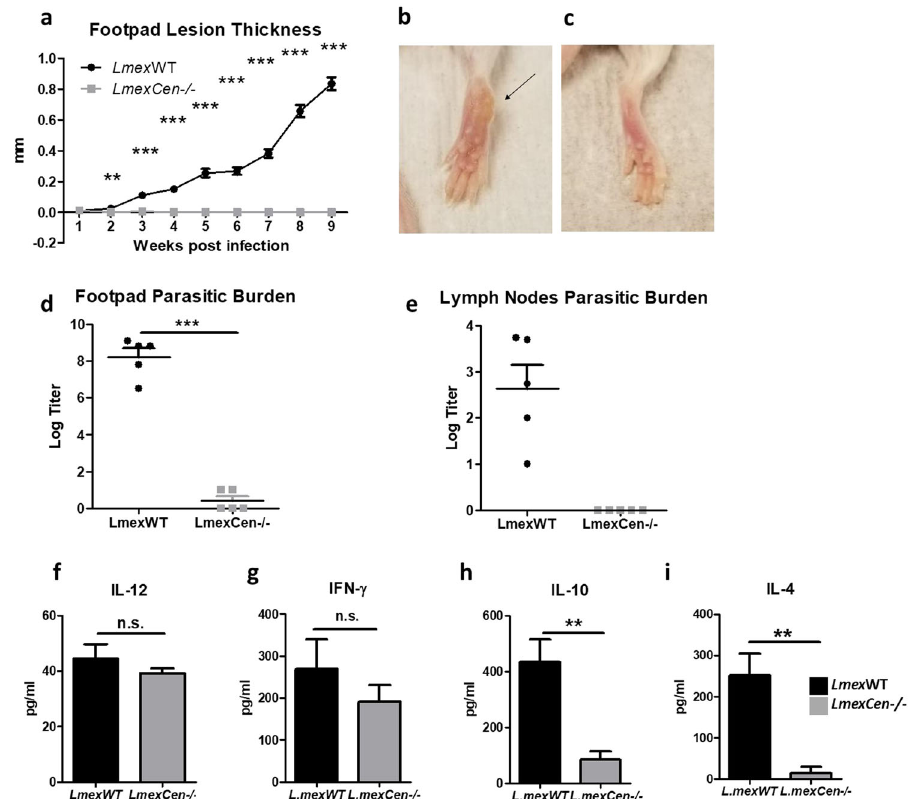
Fig. 4 LmexCen − / − parasites do not cause lesions and induce a protective immune response in vivo. For this experiment, BALB/c female mice were inoculated in the footpad with 2 × 10 6 Lmex WT or LmexCen − / − promastigotes in the stationary phase. a Lesion thickness in the infected footpad. b , c Representative pictures of footpad inoculated with either Lmex WT ( b ) or LmexCen − / − ( c ) promastigotes at 9 wpi. d , e Parasitic burden in the footpad ( d ) and draining lymph nodes ( e ) at 9 wpi. f – i Cytokine levels of IL-12 ( f ), IFN- γ ( g ), IL-10 ( h ), and IL-4 ( i ) in the draining lymph nodes at 9 wpi. Data show one representative experiment out of two independent experiments and show mean ± SEM, N = 5 for each group at each time point. Unpaired two-tailed Student ’ s t -test was performed to compare statistical signi fi cance at each time point. A P -value < 0.05 was considered signi fi cant. In all panels * represents P ≤ 0.05, ** represents P ≤ 0.01, and *** represents P ≤